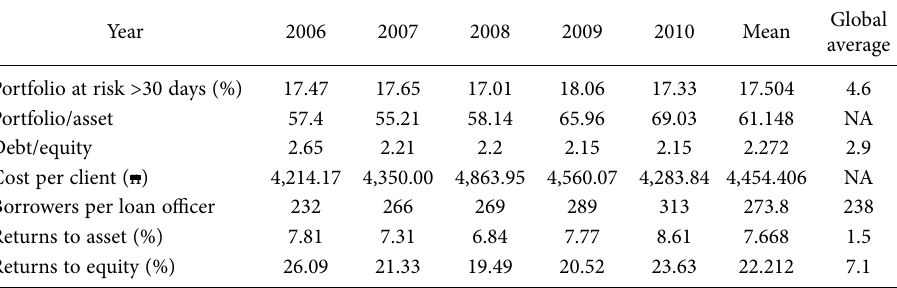
Table 1. Average Performance of Sampled MFBs (2006 to 2010) using Ratio